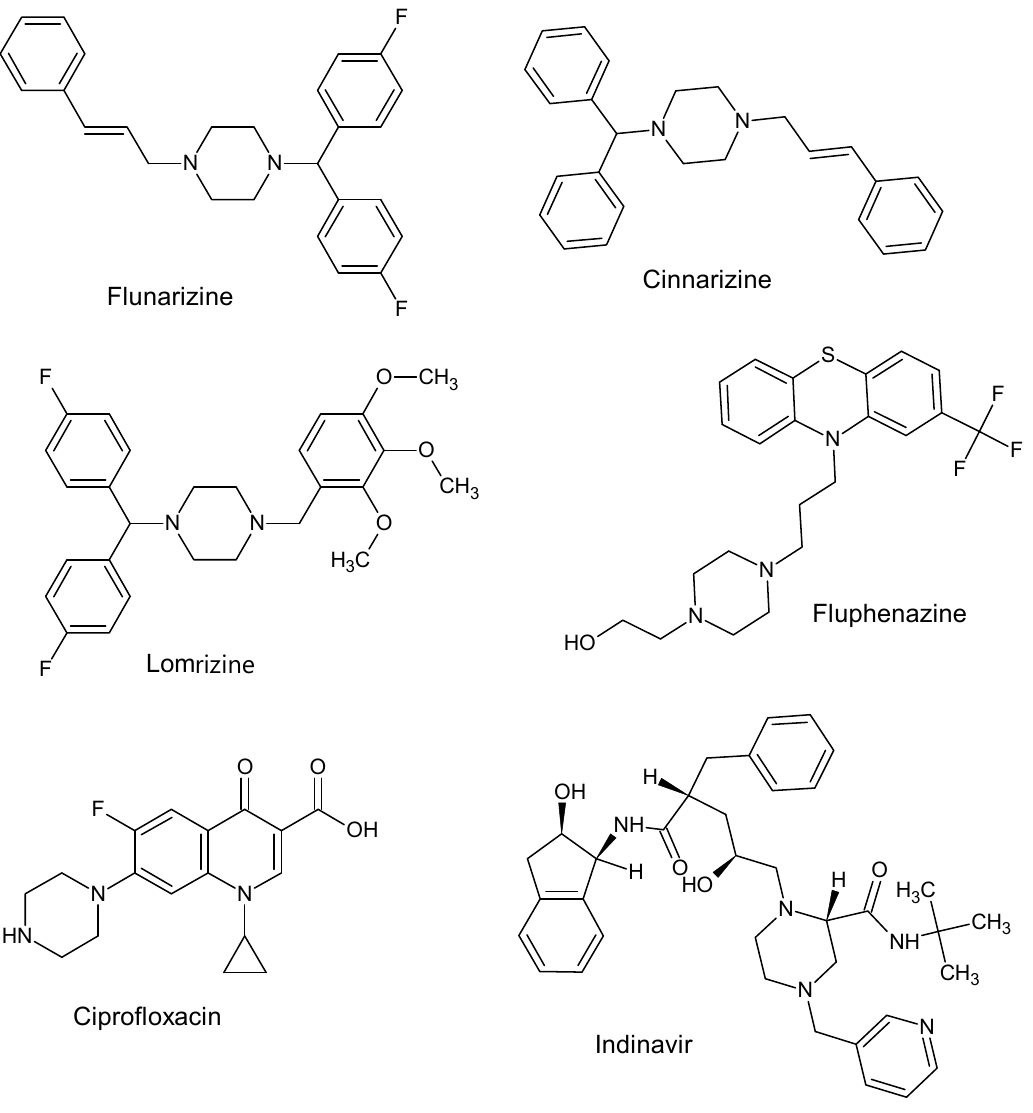
Figure 1. Marketed drugs containing piperazine moiety.